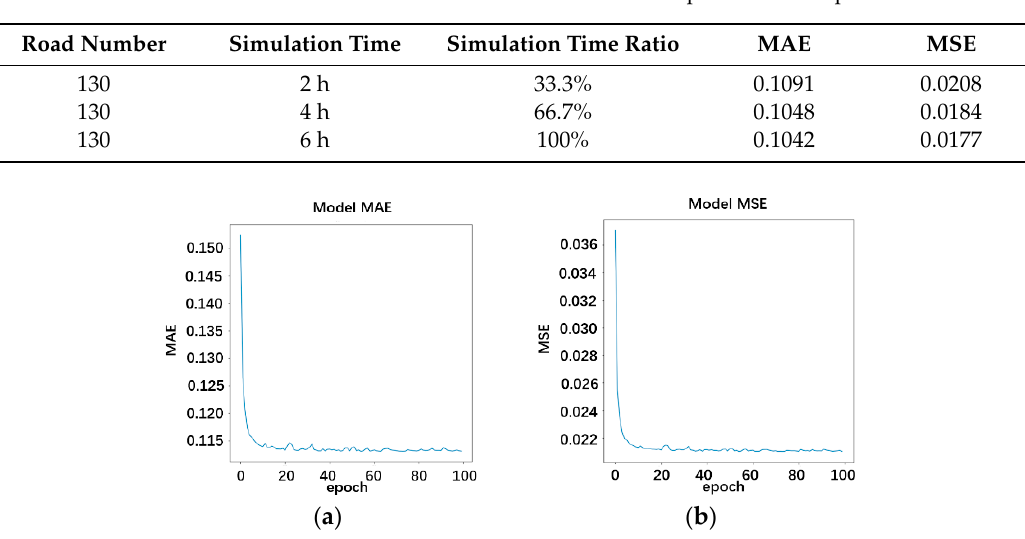
Table 6. The influence of the number of roads in the model input data on the prediction results.